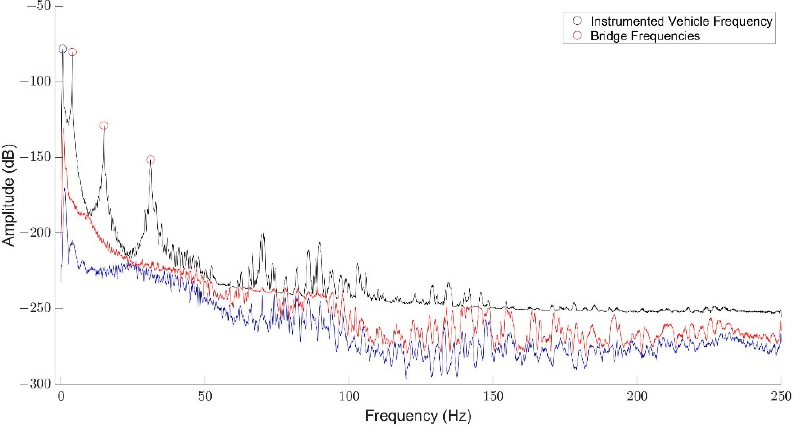
Figure 3. Singular value plots (no roughness, no noise). First singular values (black line), second singular values (red line), third singular values (blue line).